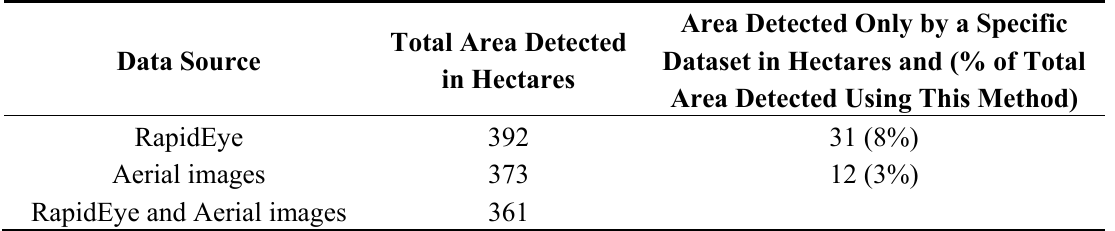
Table 5. Calculated forest losses by data and method utilized.